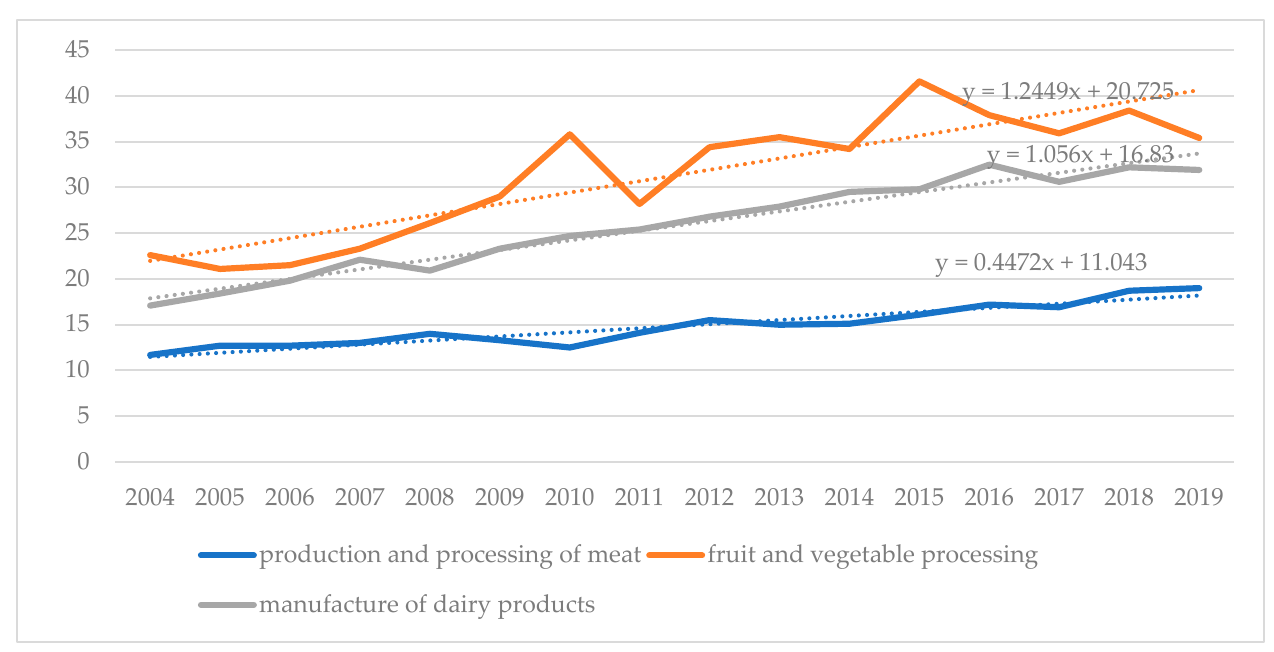
Figure 2. Electricity consumption in selected branches of the food industry in MWh per employee. Source: own elaboration based on [77,80,82,83].